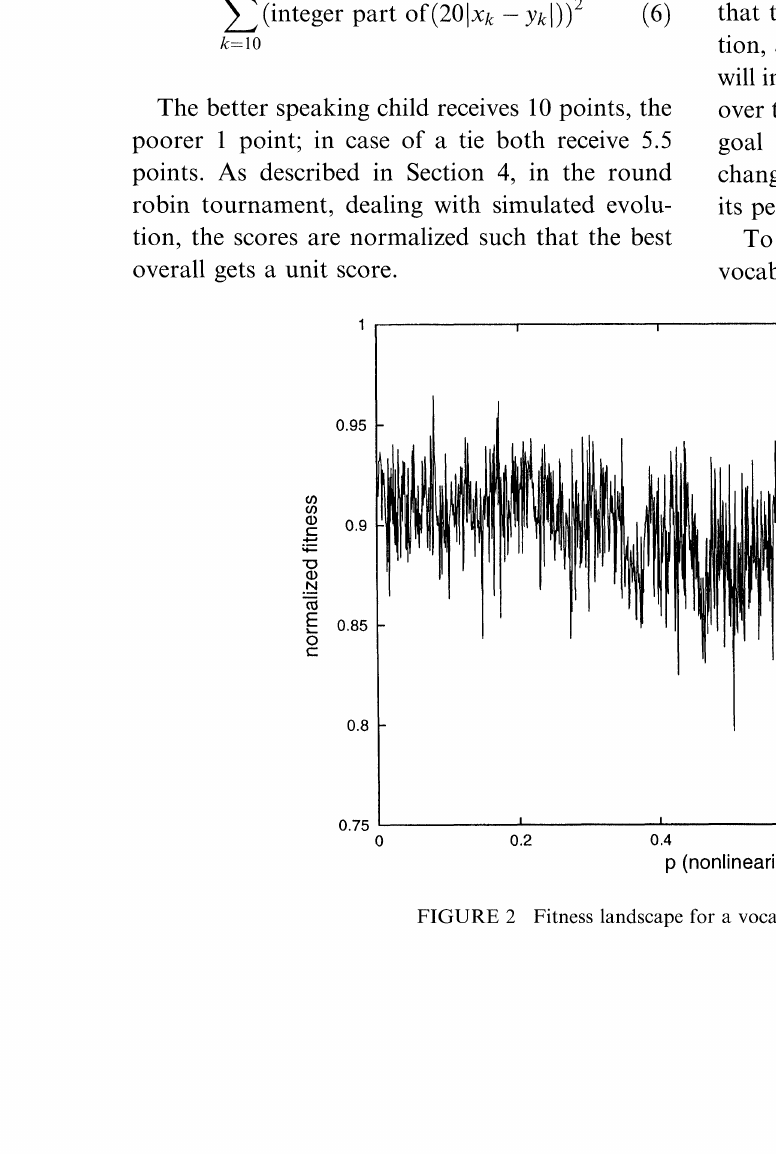
FIGURE 2 Fitness landscape for a vocabulary with two